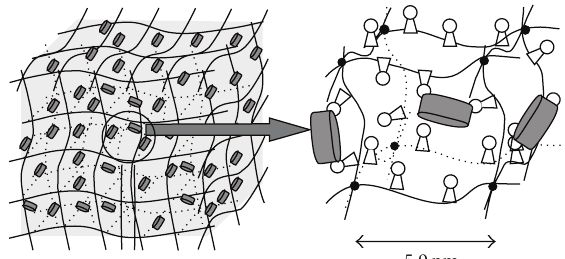
Figure 3: Scheme of a pHEMA-co-GMA hydrogel with pendant β - CDs